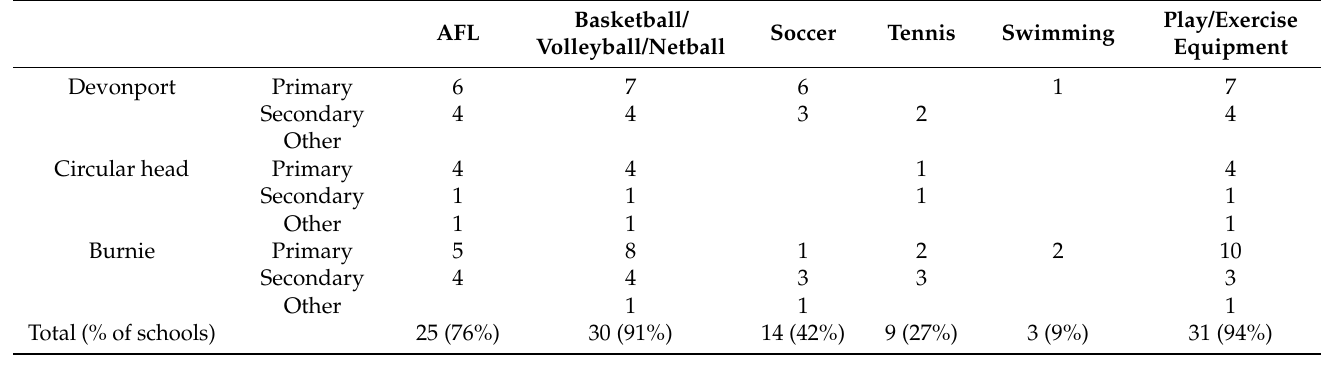
Table 2. Available facilities stratified by school type and location.